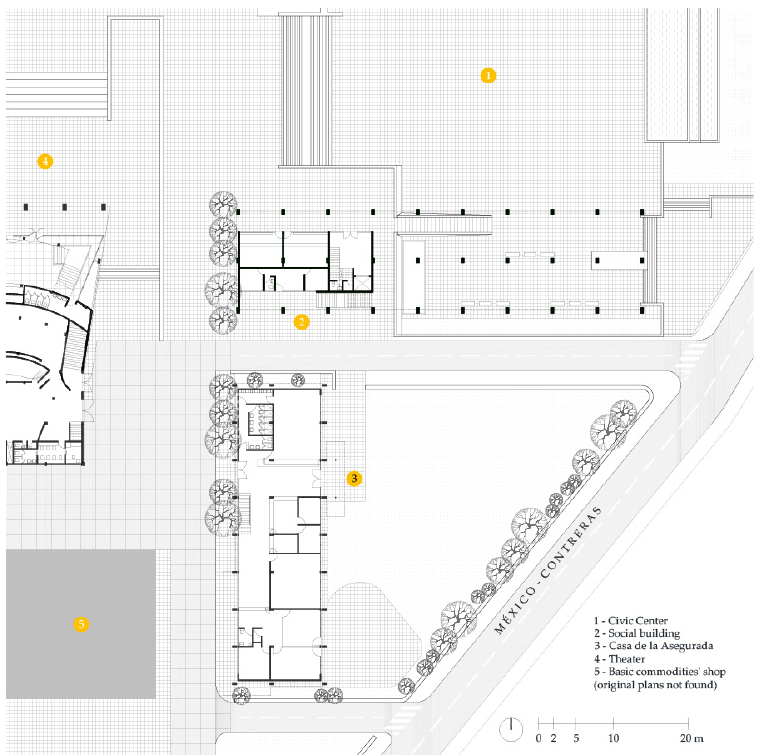
Figure 8. Ground floor plan of the Casa de la Asegurada and the adjacent facilities at the Unidad Independencia housing complex. Source: own creation, 2021.